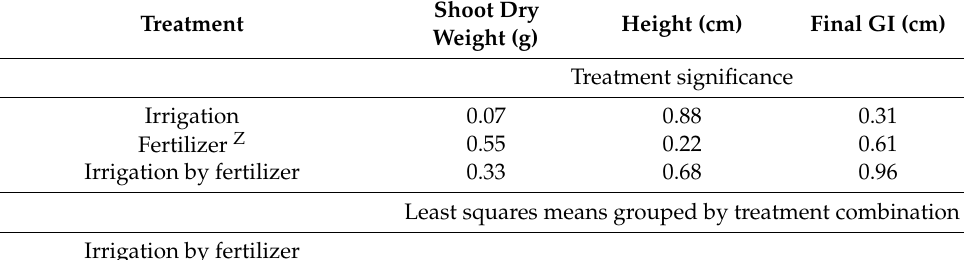
Table 2. Shoot dry weight, height, and growth index of ‘Mellow Yellow’ coneflower in response to substrate volumetric water content (VWC) and fertilizer rate treatments at the conclusion of the 69 d experiment, the 40% VWC treatment was considered well-watered while the 18% treatment supplied a reduced irrigation treatment. Shoots were cut off at the substrate surface and were dried at 50 ◦ C for 1 week after which dry weight was determined. Growth index (GI) was calculated as follows: (height + width 1 + width